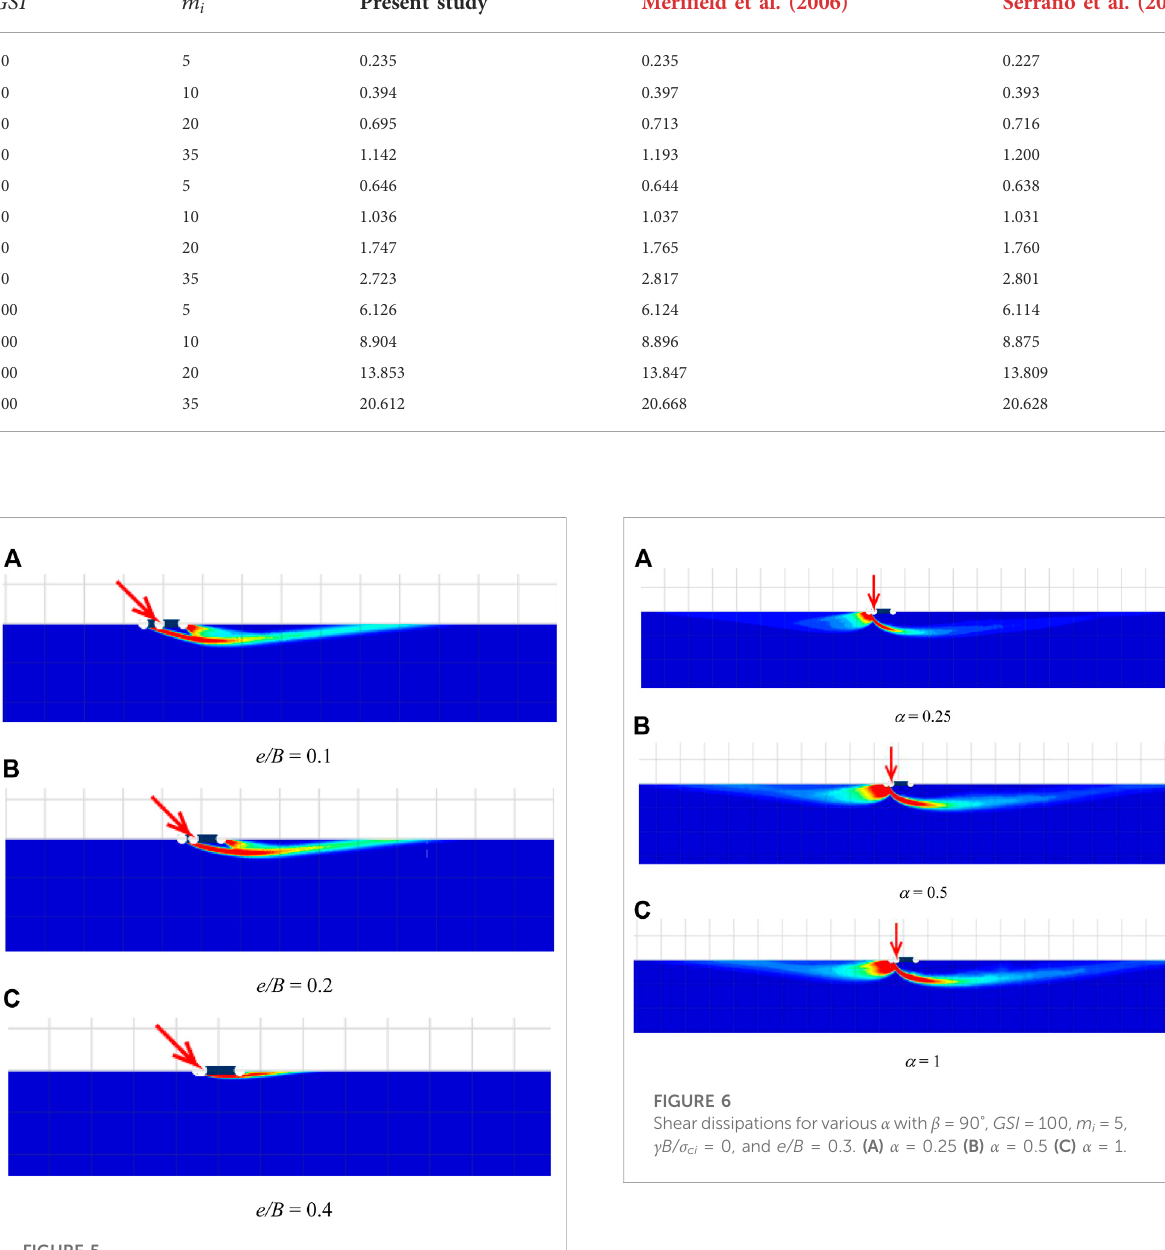
TABLE 2 Bearing capacity comparison of a footing on rock mass with γ B/ σ ci = 0, β = 90 ° , e/B = 0, and α = 1. GSI m i Present study Meri fi eld et al. (2006) Serrano et al. (2000)